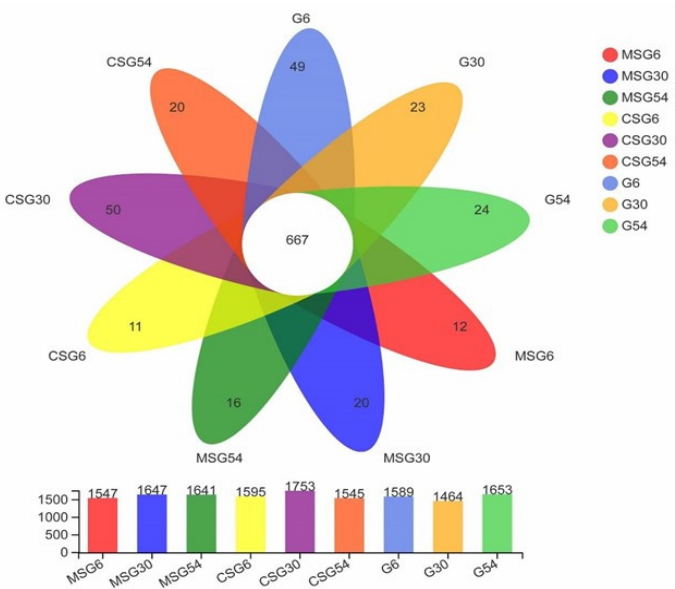
Figure 1. Venn diagram of luminous bacterial OTUs. Parts of no overlap represent unique OTUs of diets at 6M, 30M, and 54M. MSG represents composite straw pellets and grazing; CSG represents corn straw pellets and grazing; G represents grazing.